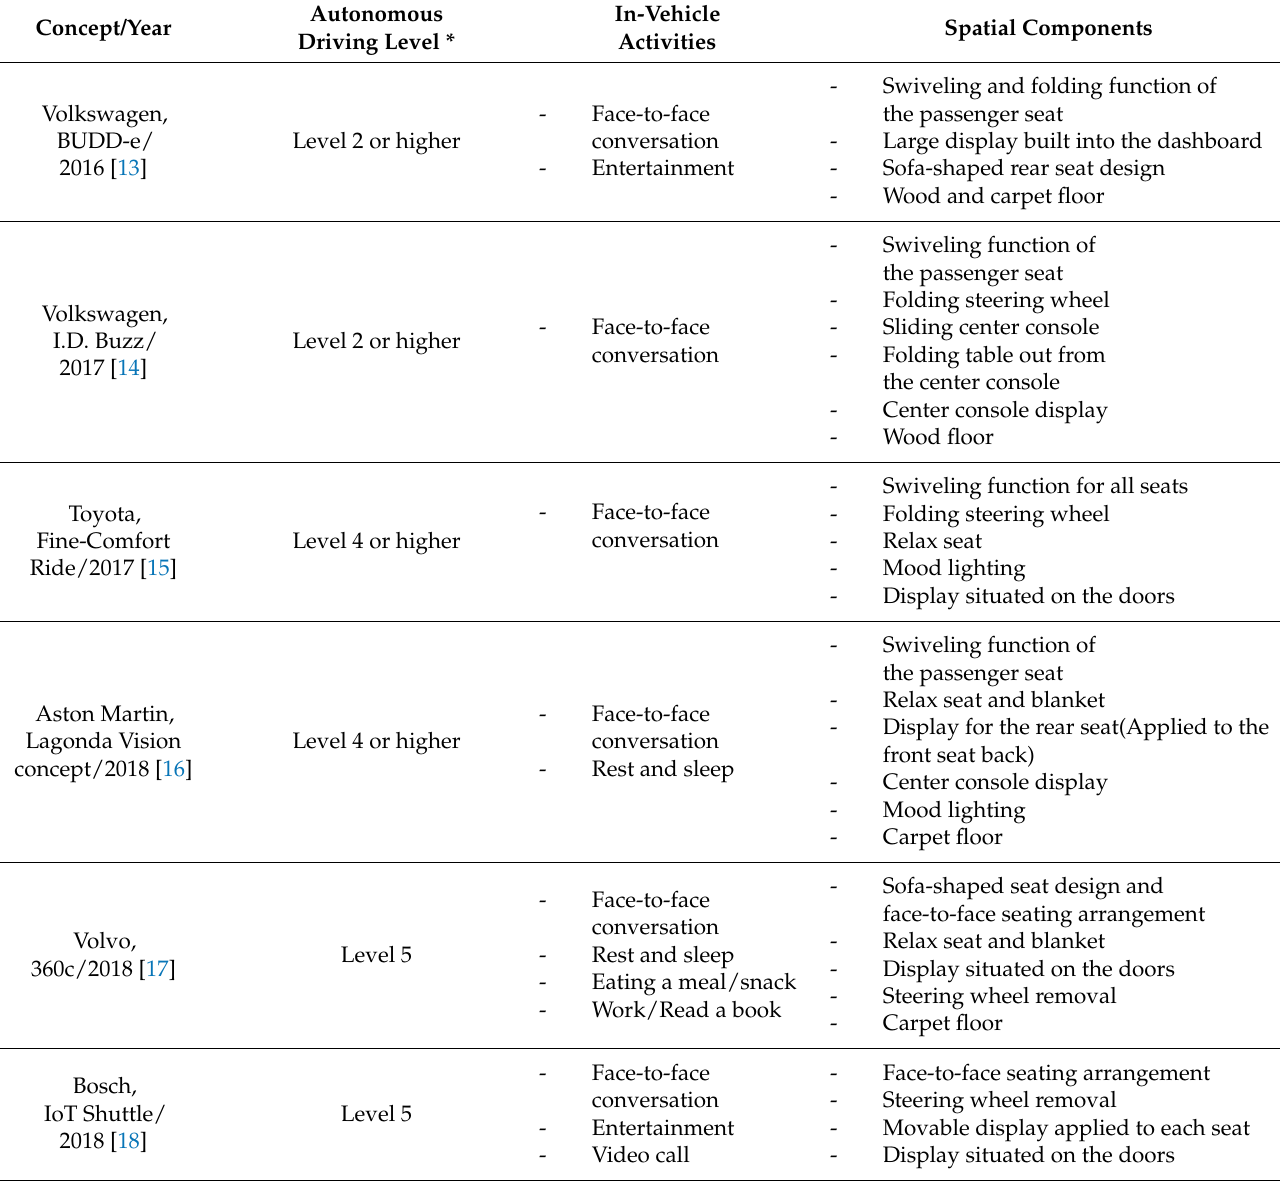
Table 1. Analysis of the spatial design of the autonomous vehicle concept of the face-to-face seating arrangement and in-vehicle